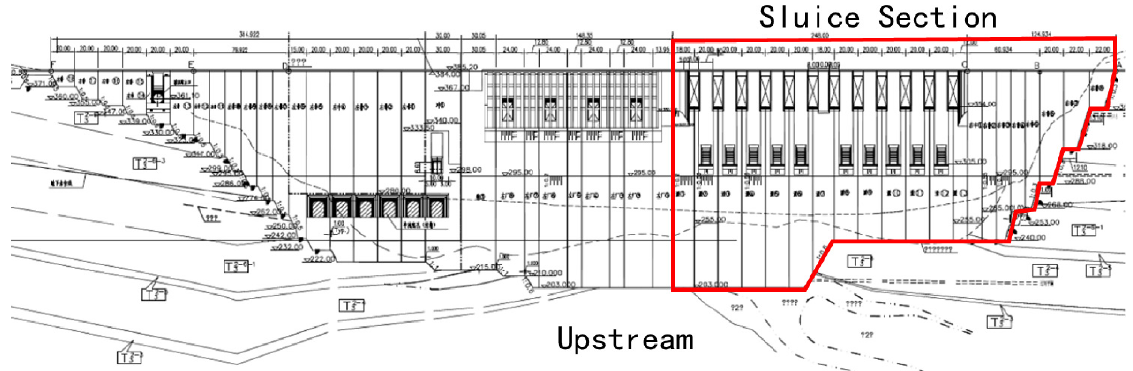
Figure 5. Upstream vertical view of the whole dam.